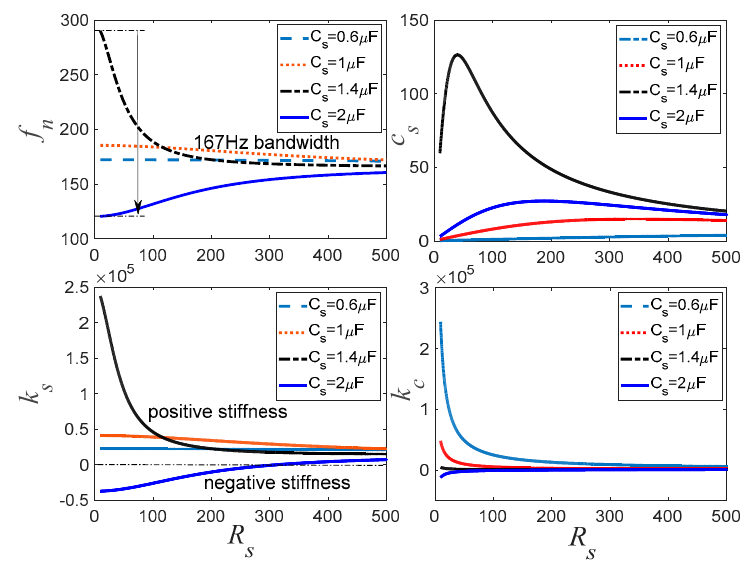
Sensors 2019 , 19 , x FOR PEER REVIEW ff ness analysis for the negative capacitance in series with R Figure 6. Controlled stiffness analysis for the negative capacitance in series with R s shunt. Figure 6. Controlled sti